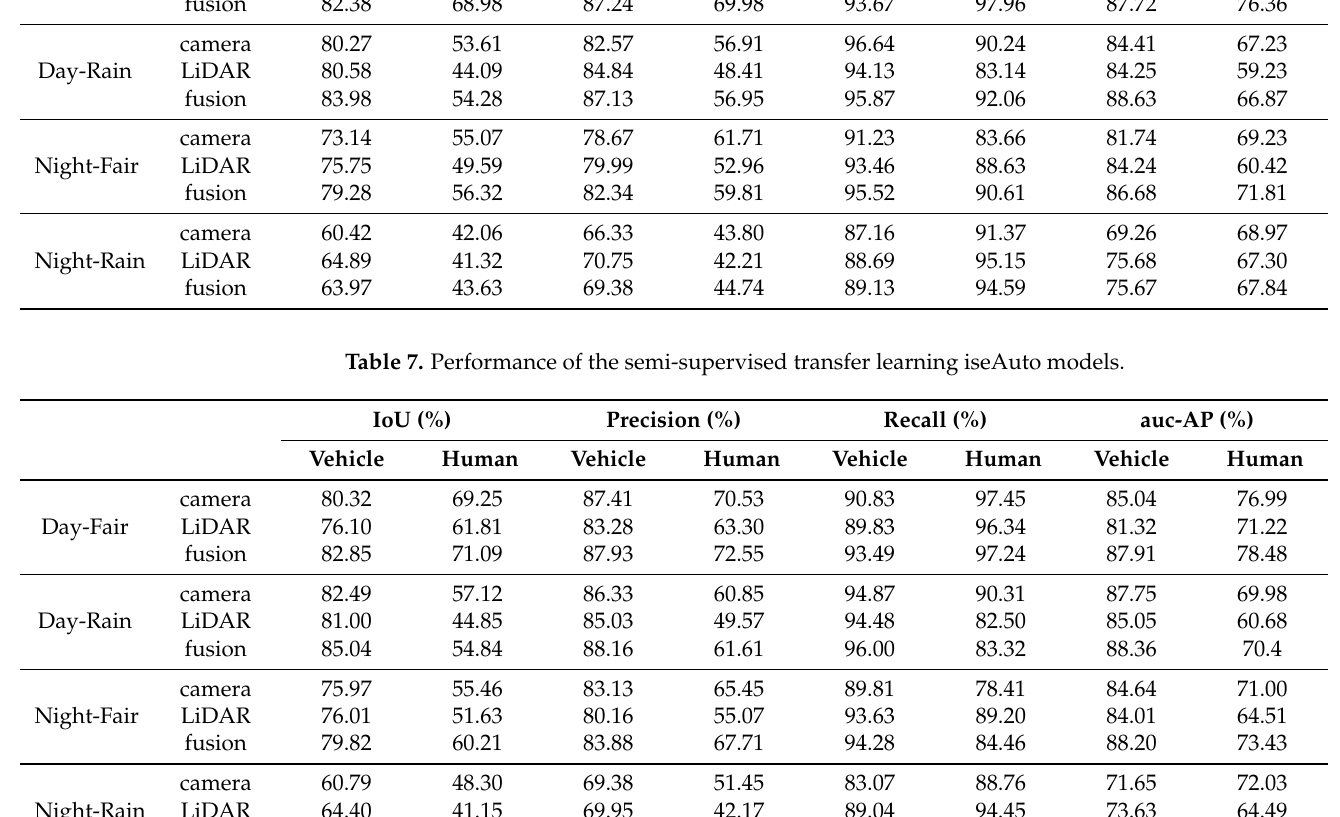
Table 7 evaluates the semi-supervised learning iseAuto models with the transfer learning knowledge from the Waymo dataset. The best-performing Waymo supervised learning baseline models were continuously trained by full-annotated iseAuto